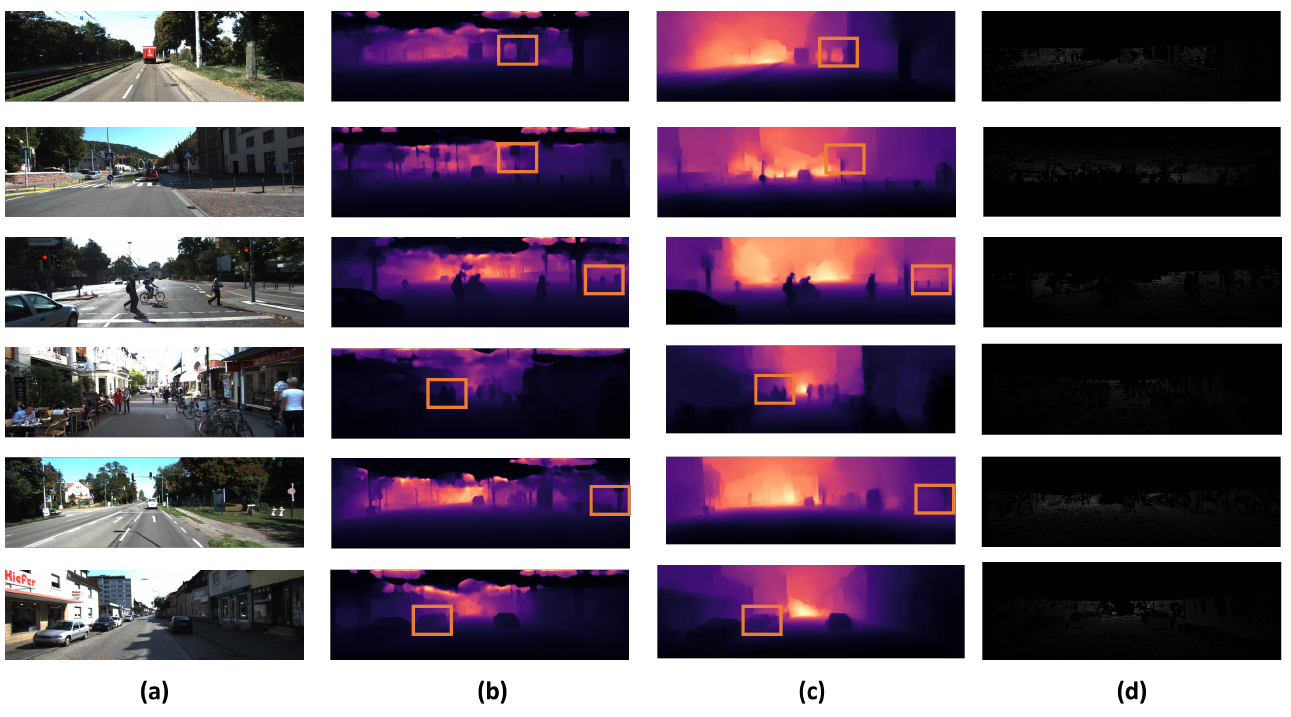
Figure 4. The KITTI qualitative results of different methods for six images (Eigen split): ( a ) RGB images, ( b ) our results, ( c ) results of Alhashim [38], and ( d ) ground-truth from